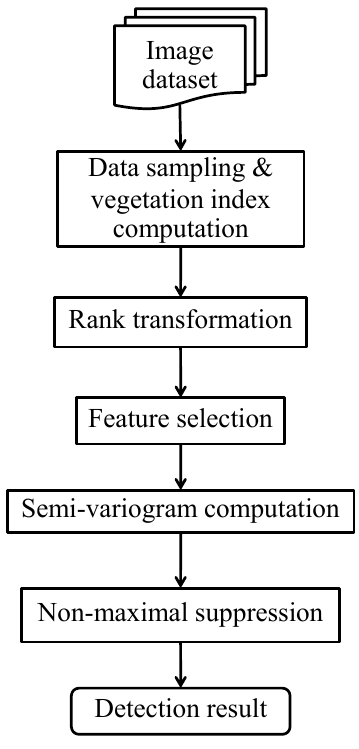
Figure 1. Workflow of the proposed method. Please see text for detailed explanation.